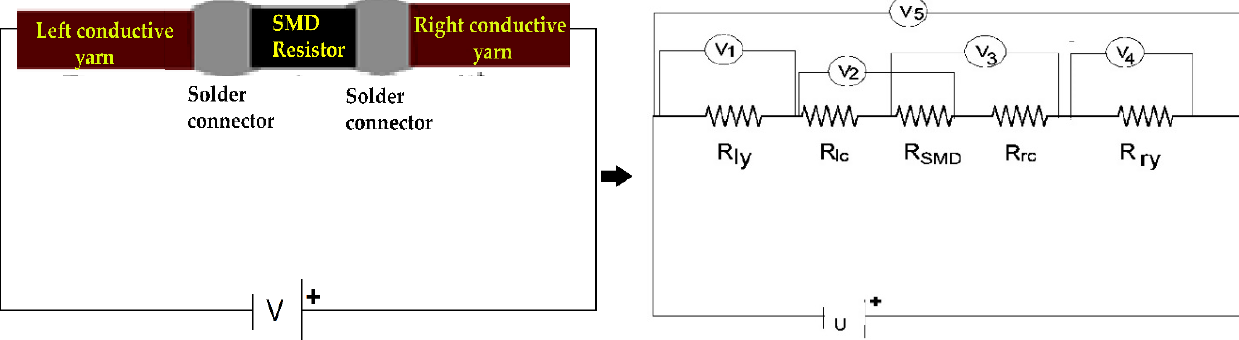
Figure 6. Schematic diagram of different resistors found in the E yarn and measurements of voltage drop down at each